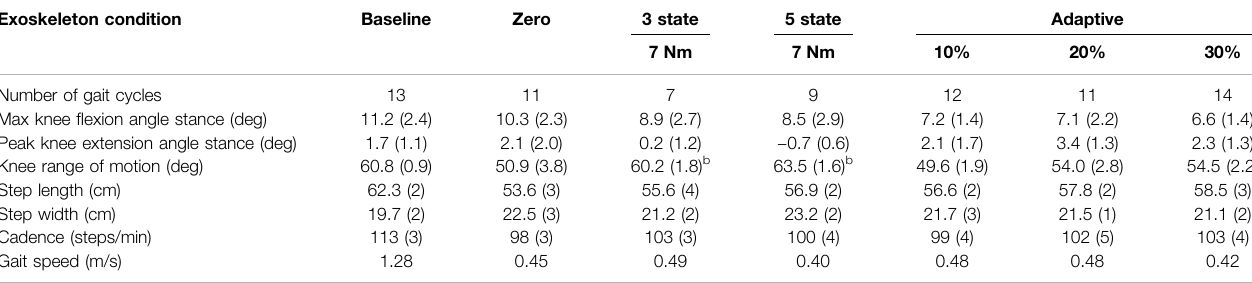
TABLE 2 | Spatiotemporal and kinematic outcomes during exoskeleton walking in participant with typical development a . Exoskeleton condition Baseline